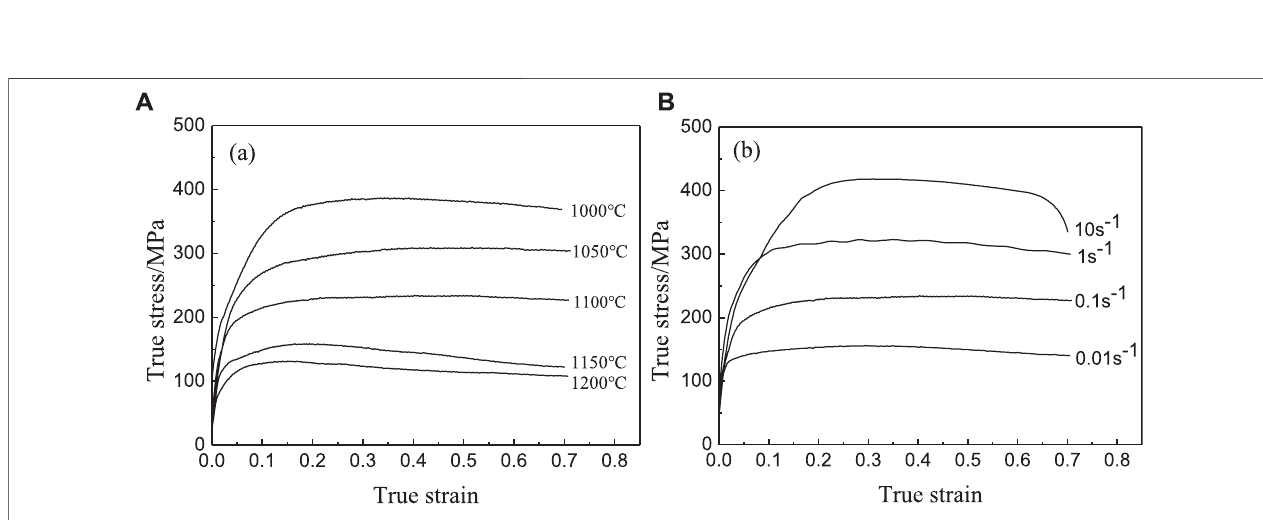
FIGURE 2 | Typical true stress – strain curves for the studied superalloy under (A) different temperatures at a strain rate of 0.1 s − 1 and (B) different strain rates at a temperature of 1,100 ° C.